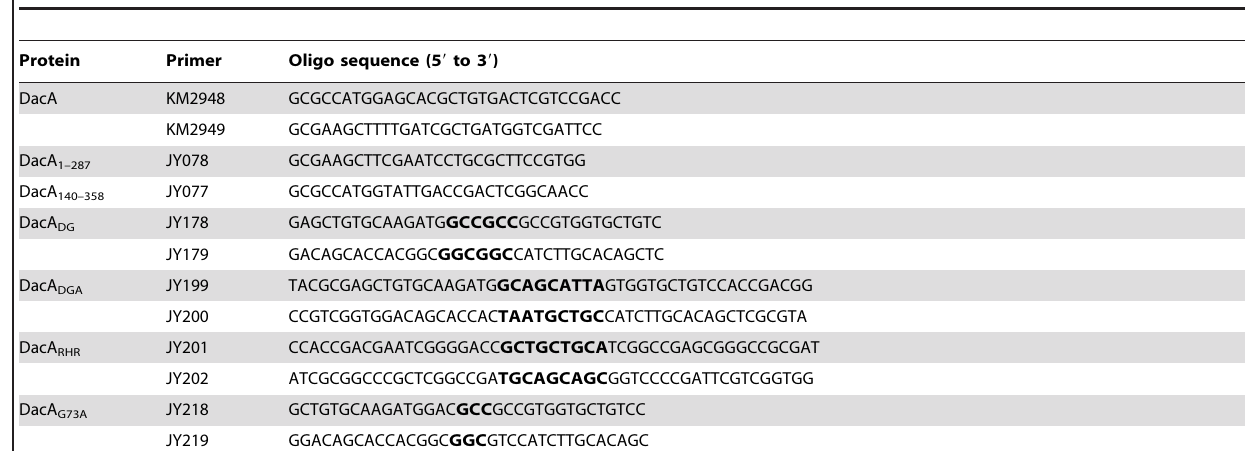
Table 1. Primers used for protein expression in this study a